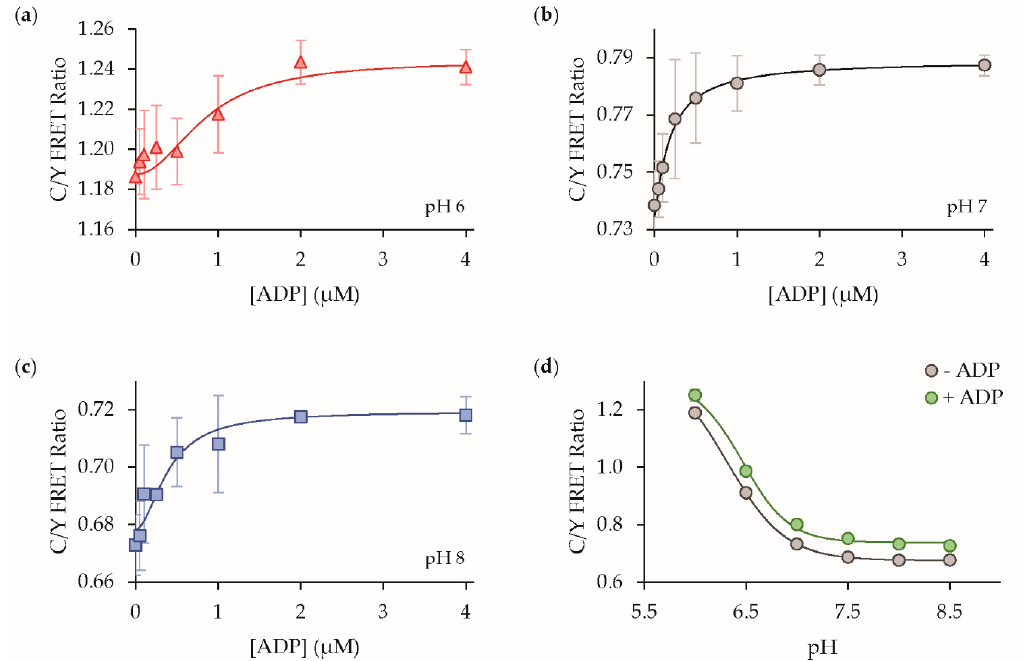
Figure 8. The pH sensitivity. ADP dose response curves at ( a ) pH 6 (K d = 0.85 ± 0.29 mM); ( b ) pH 7 (K d = 0.19 ± 0.07 mM); ( c ) and pH 8 in solution (K d = 0.40 ± 0.10 mM); ( d ) The sensor is sensitive to changes in the absolute ratio values at pH 6.5 and below, but it is insensitive to pH changes above pH 7, mean ± std (n = 3).